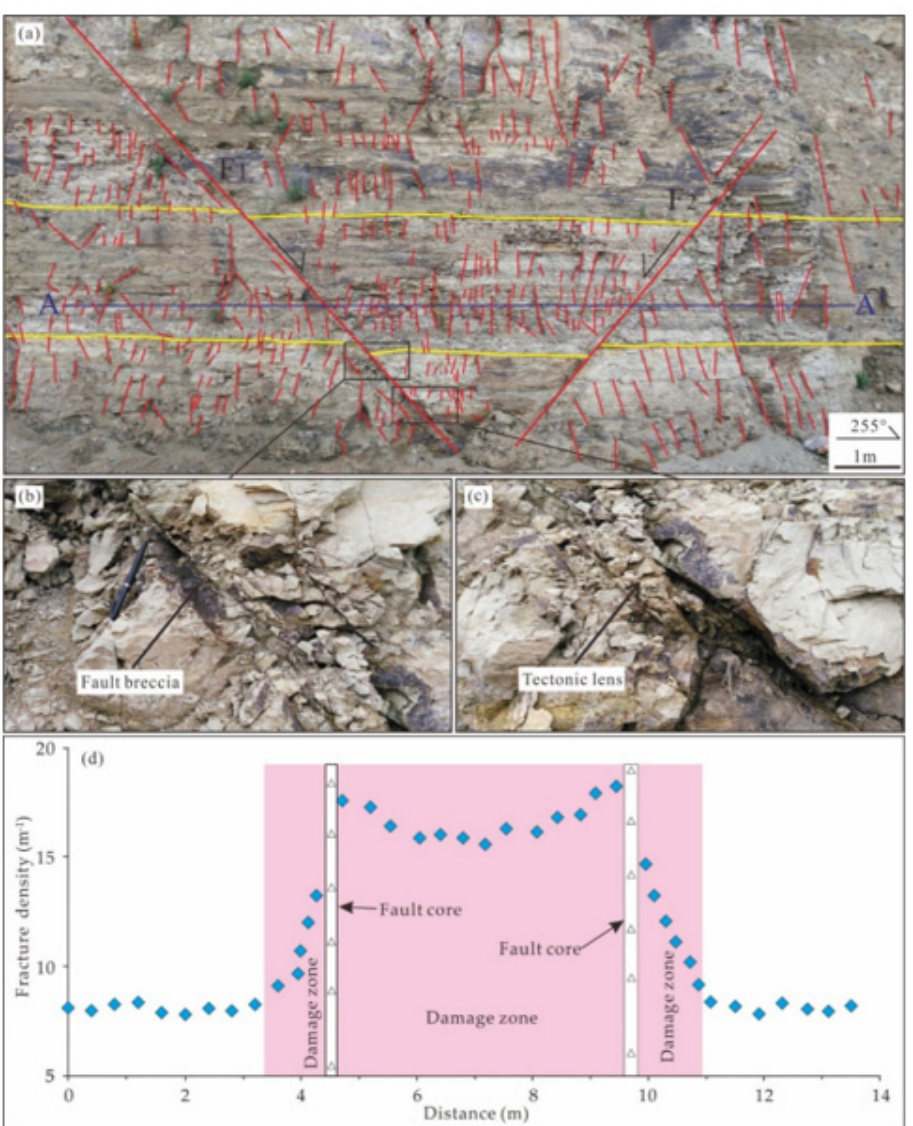
Figure 12. Two small, normal faults at Niaohetun outcrop in Bin County, Haerbin City: ( a ) Photos of these two small, normal faults; ( b ) fault breccia; ( c ) tectonic lens; ( d ) internal structure of fault zone and fracture distribution.